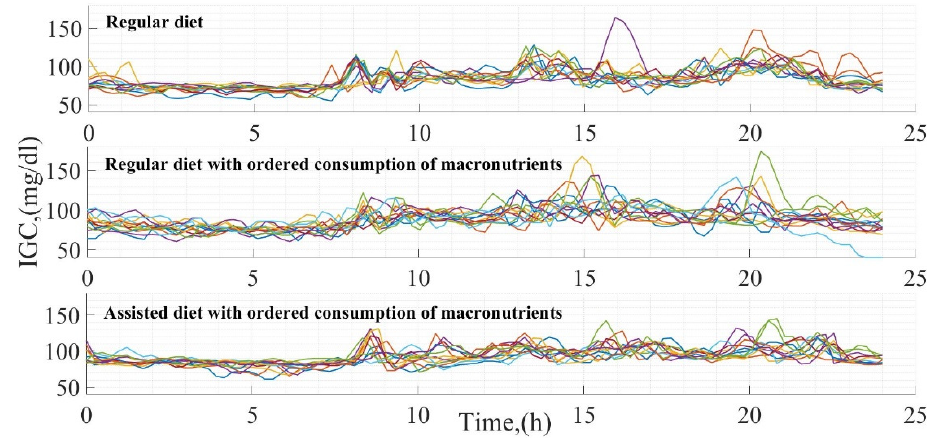
8 of 14 Figure 1. Glucose curve description. 3. Results 3.1. Glucose Measurement In each test, 14 days of glucose measurements were generated. The result of the glu- cose variation in each test is presented in Figure 2, positioning in the upper part the glu- cose dynamics according to a daily diet (Test 1), in the central part the dynamics according